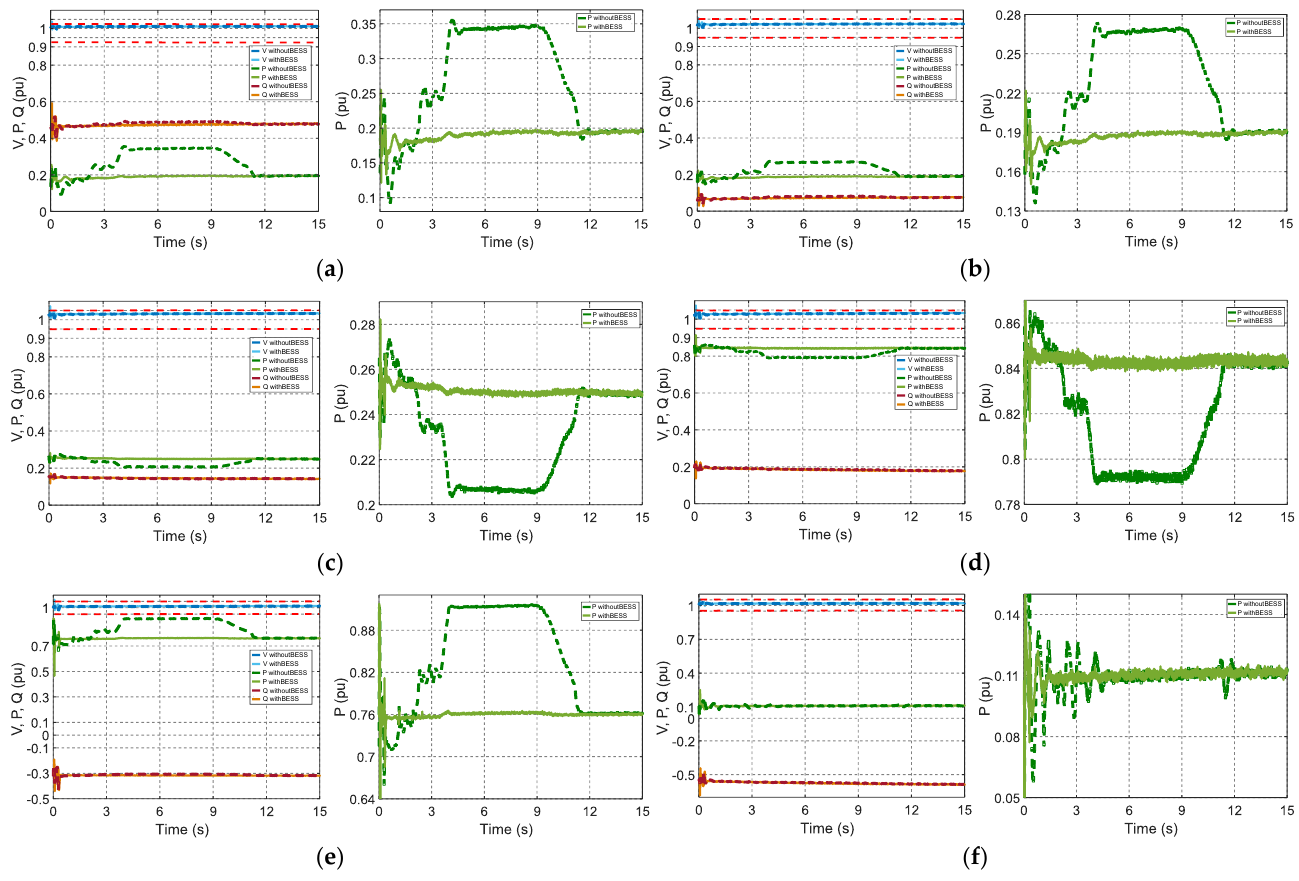
Figure 19. Scenario 3 results for the system buses: voltage (V), active power (P), reactive power (Q), and active power zoom. ( a ) Bus 1; ( b ) bus 2; ( c ) bus 3; ( d ) bus 4; ( e ) bus 5; ( f ) bus 6.